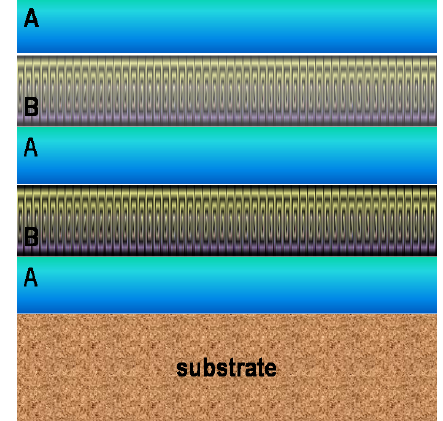
Figure 1: Schematic diagram of